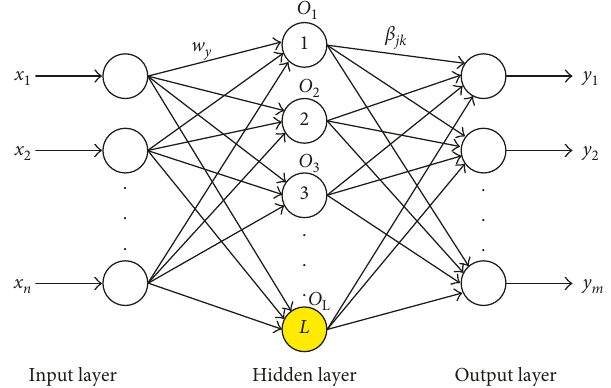
Figure 3: Network structure of I-ELM by adding hidden layer nodes.